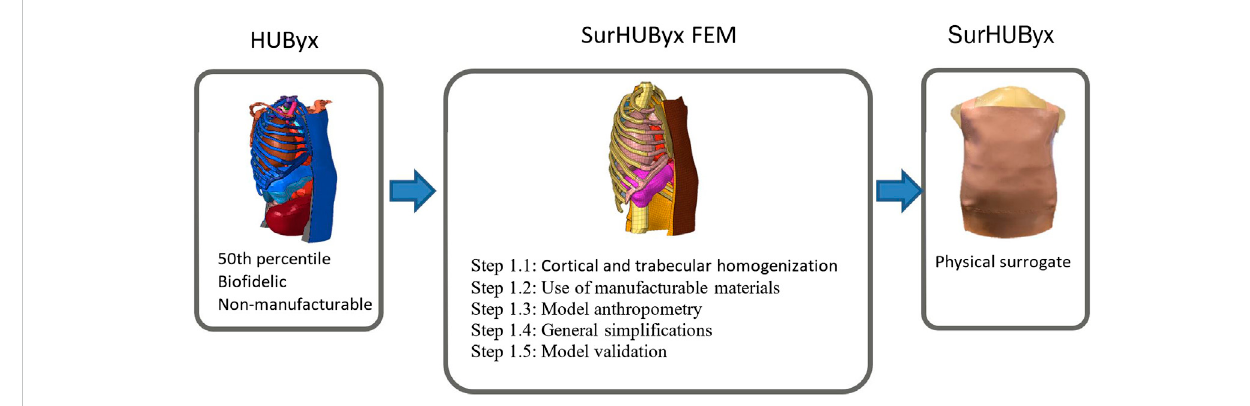
FIGURE 1 Reverse engineering procedure: from a fi nite element model to its physical twin.